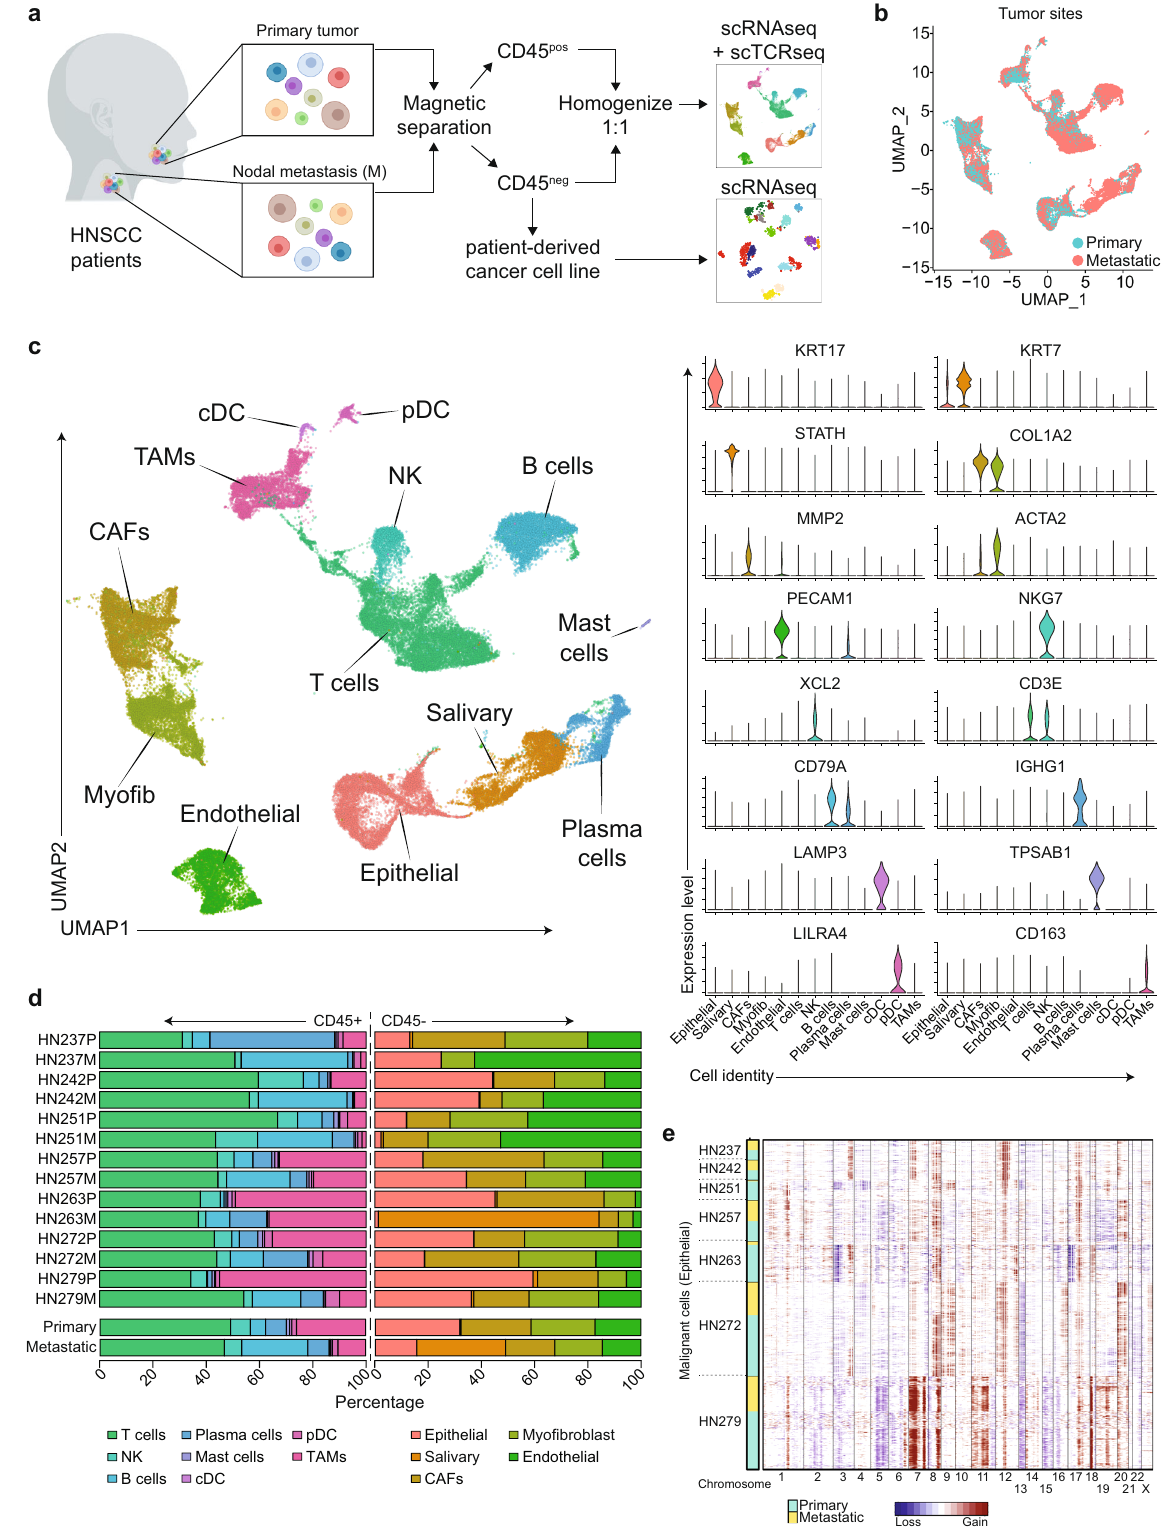
algorithm 28 , which identi fi ed AXL , Aurora kinase, TYMS and